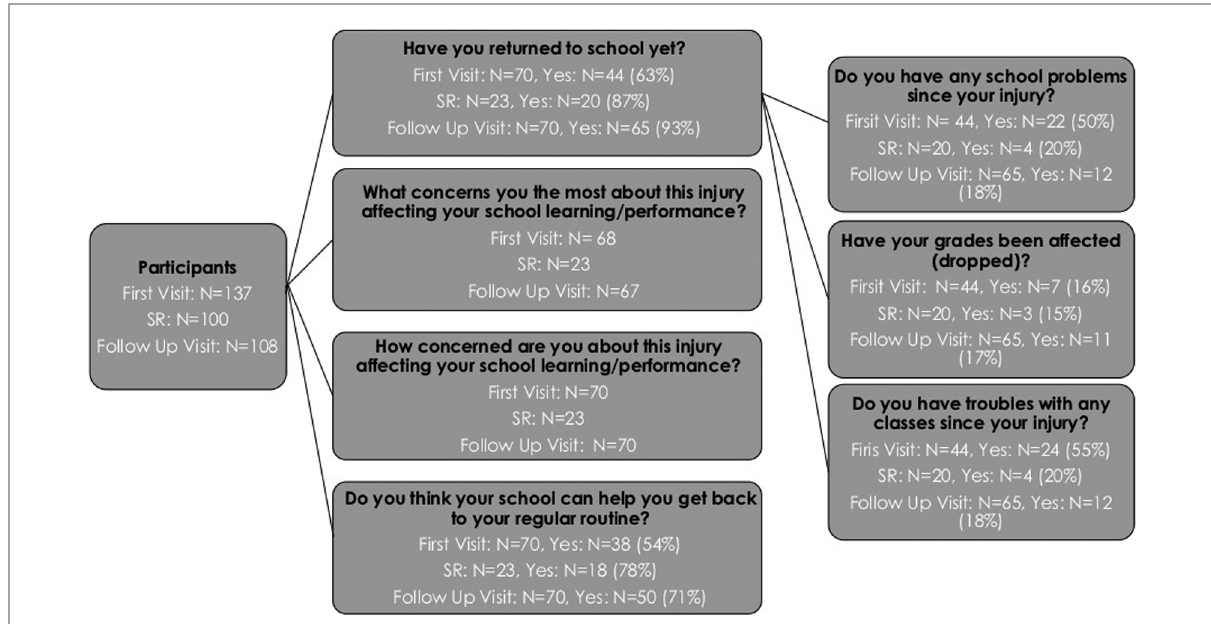
FIGURE 1 REDCap Question stems. Participants attended 3 in person assessments: First visit post injury, In Person Symptom resolution (if applicable), and Follow Up visit which occurred 3 months post symptom-resolution or 6 months post enrolment, whichever came fi rst. Only participants recruited aged 9.5-18 years of age, recruited after July 2015, completed a school performance and information questionnaires. One hundred participants achieved symptom resolution within the study period, only 44 attended in person visits and were delivered the school information